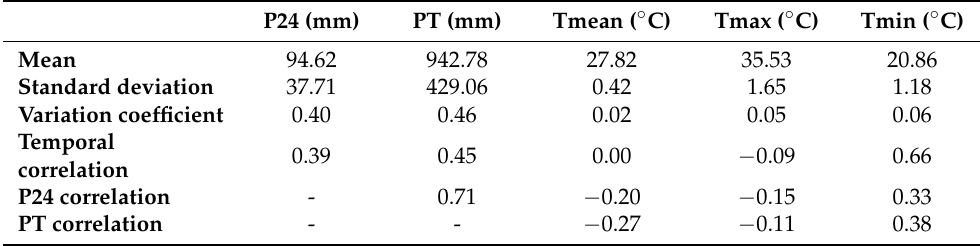
Table 1. Descriptive statistical parameters of the series under